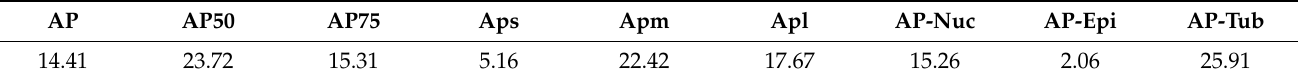
Table 7. Segmentation results on test